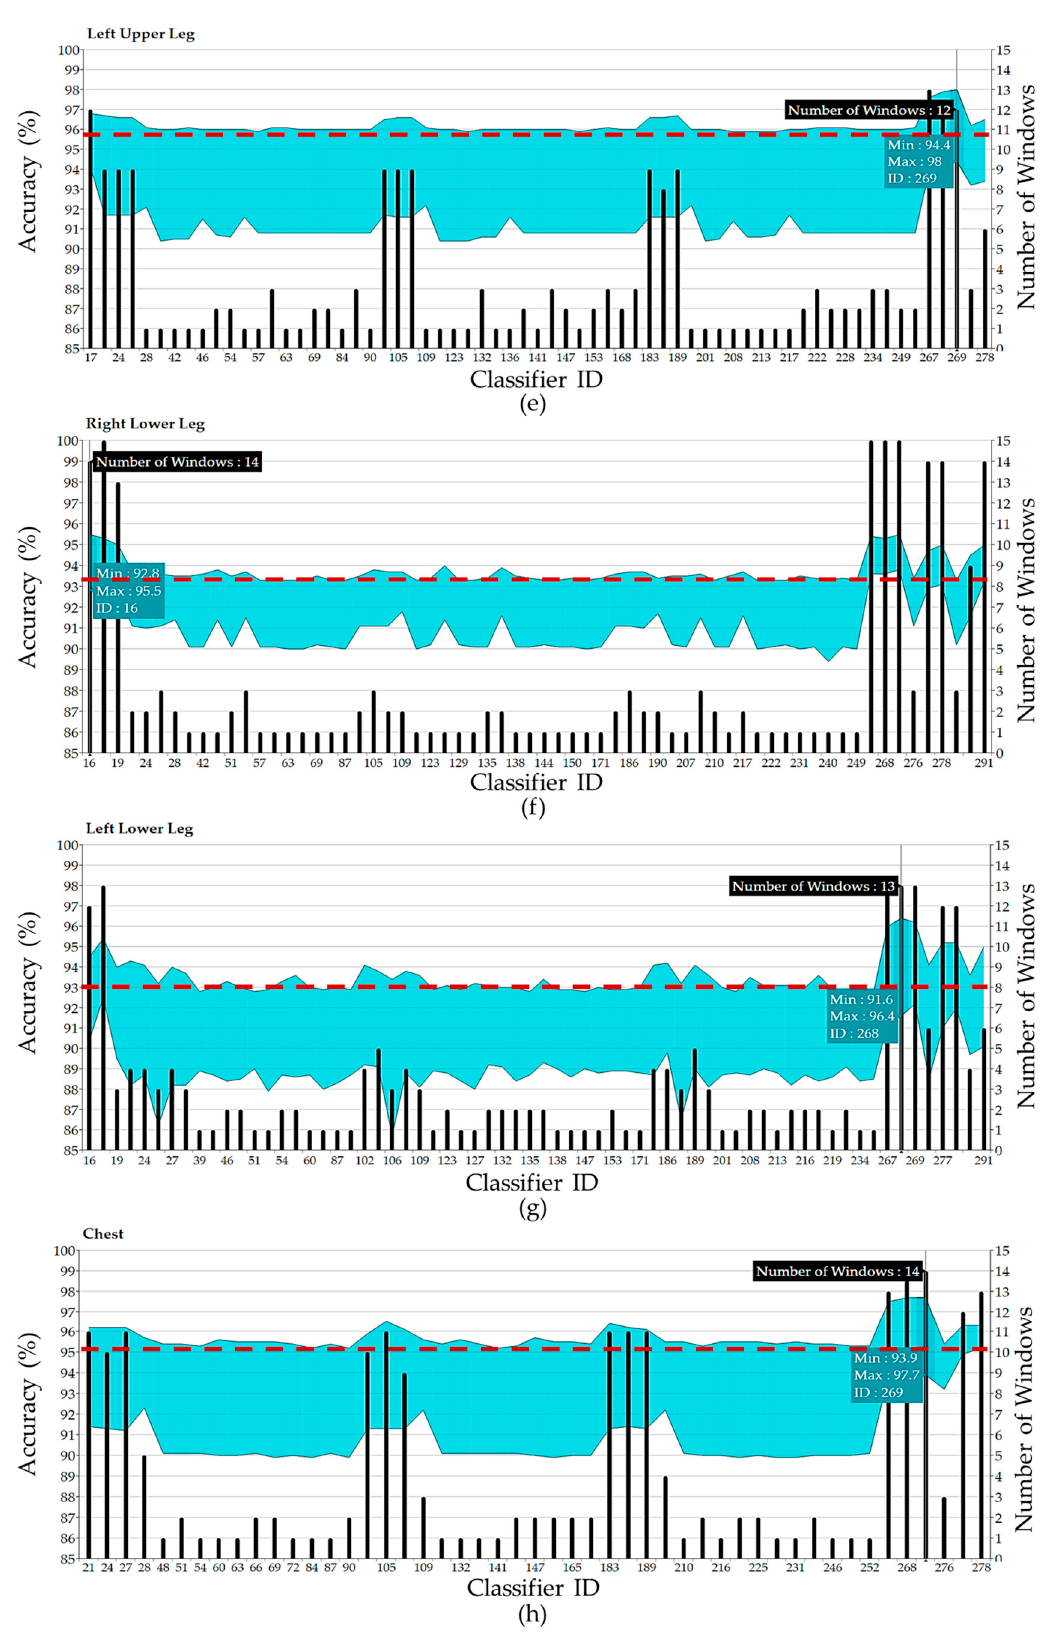
Figure 5. The range of topClassifiers accuracies for ( a ) Waist; ( b ) RLA; ( c ) LLA; ( d ) RUL; ( e ) LUL; ( f ) RLL; ( g ) LLL; and ( h ) Chest.